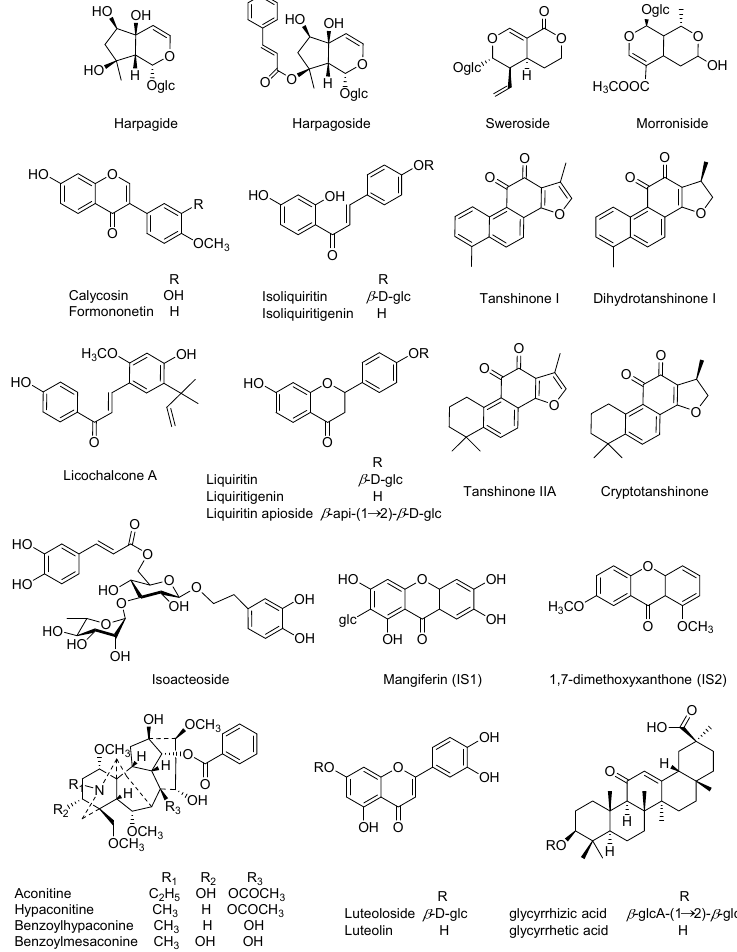
Figure 1. Chemical structures of the twenty-five analytes and internal standards.